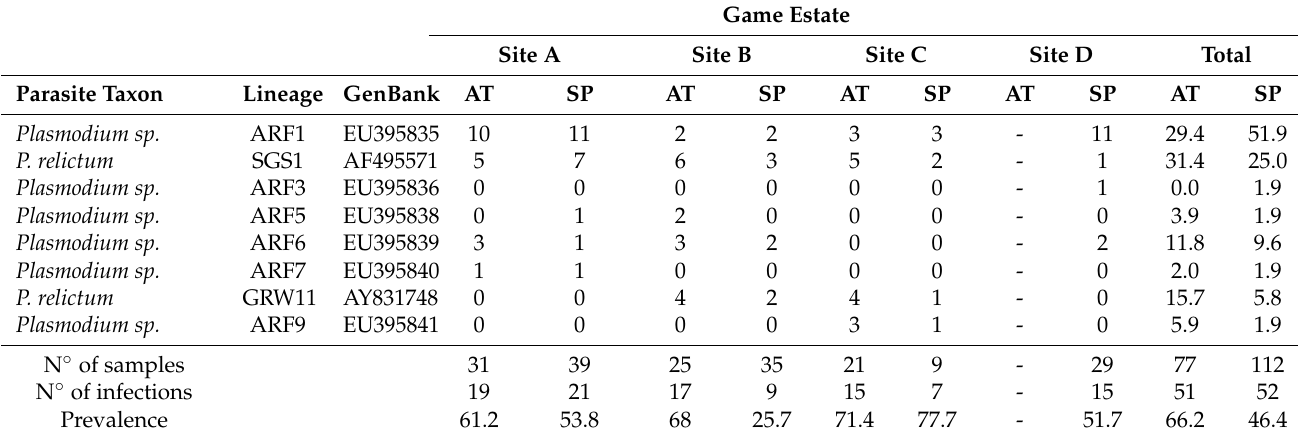
Table 1. Number of red-legged partridges infected by each malaria lineage ( Plasmodium spp .) in four study sites in central